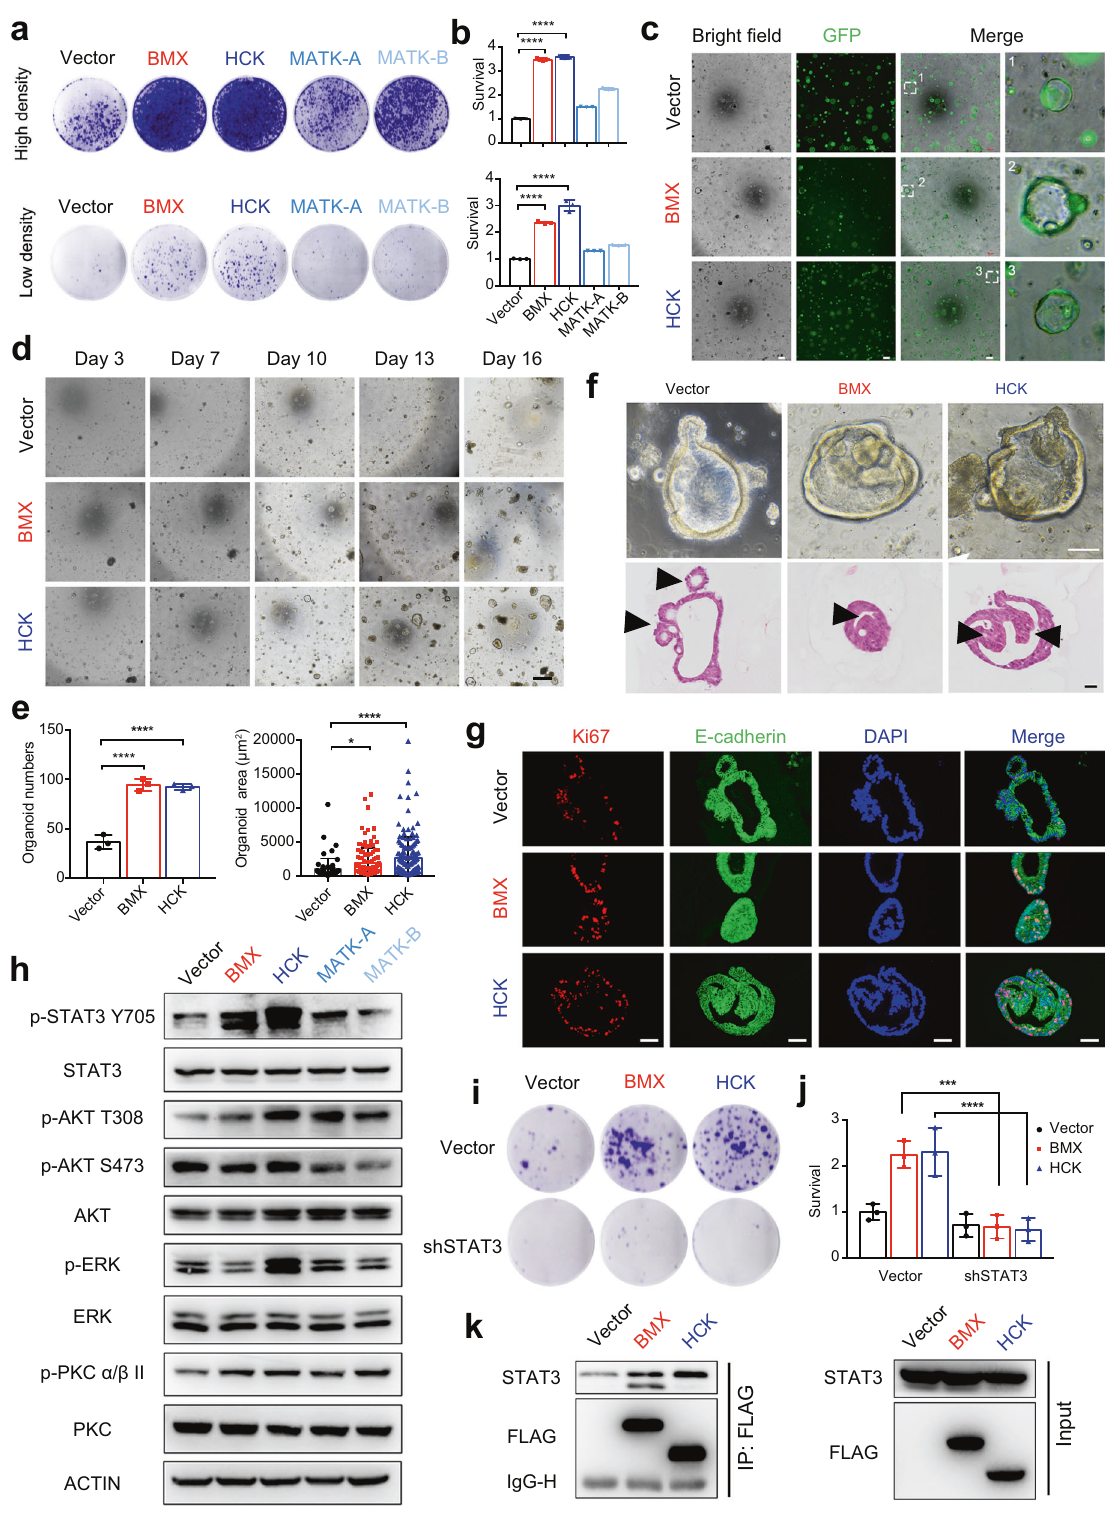
segments, a part of them were placed in liquid nitrogen or neutral buffered formalin for processing to formalin- fi xed paraf fi n- embedded blocks, and others were collected for generating single-cell suspension. Samples for single-cell suspension were preserved in DMEM (Hyclone) supplemented with 10% fetal bovine serum (NATOCOR), 1% penicillin and streptomycin Signal Transduction and Targeted Therapy (2022)